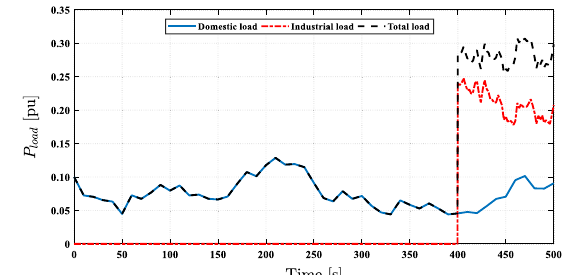
Fig. 6 The load power fluctuation of Case 1